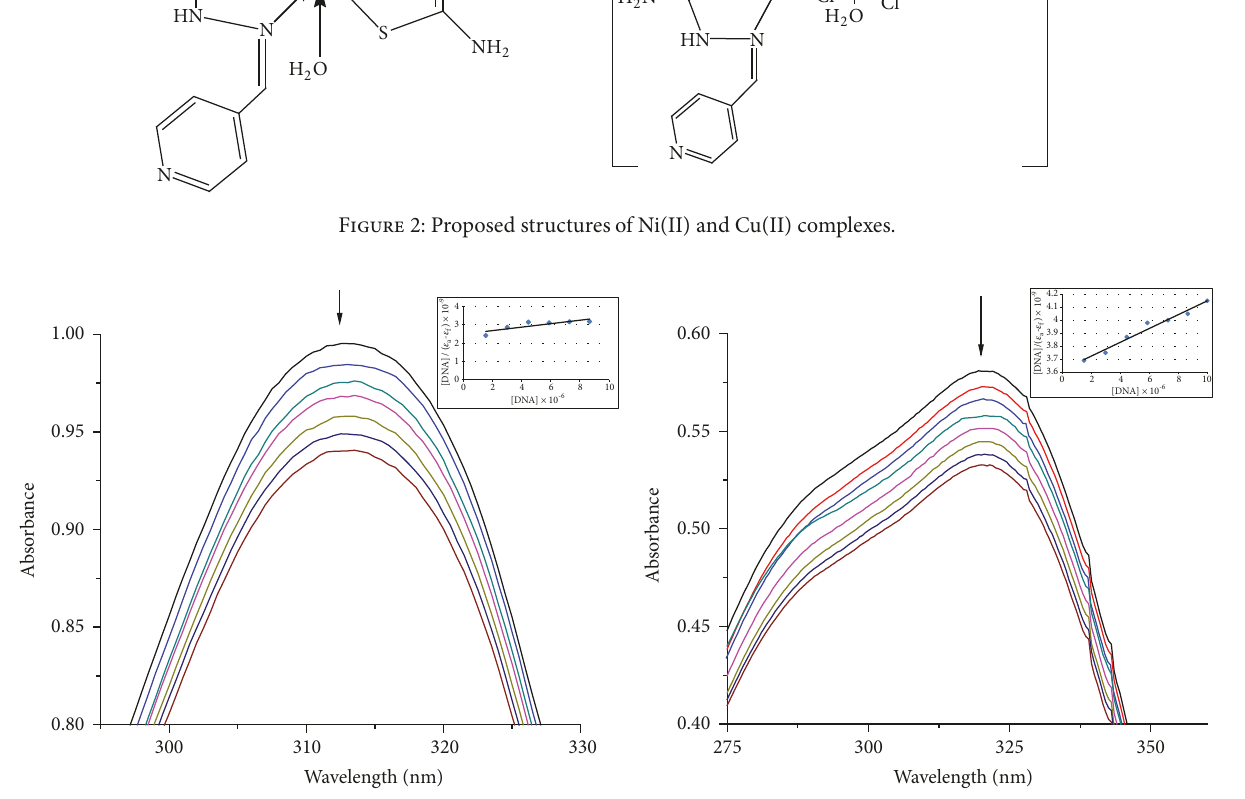
Figure 3: Absorption spectra of Ni(II) and Cu(II) complexes [20 𝜇 M] in increasing amounts (0-210 𝜇 L) of CT-DNA, [DNA]=153 𝜇 M [inset: − 𝜀 plots of [DNA] versus [DNA] / ( 𝜀 a f